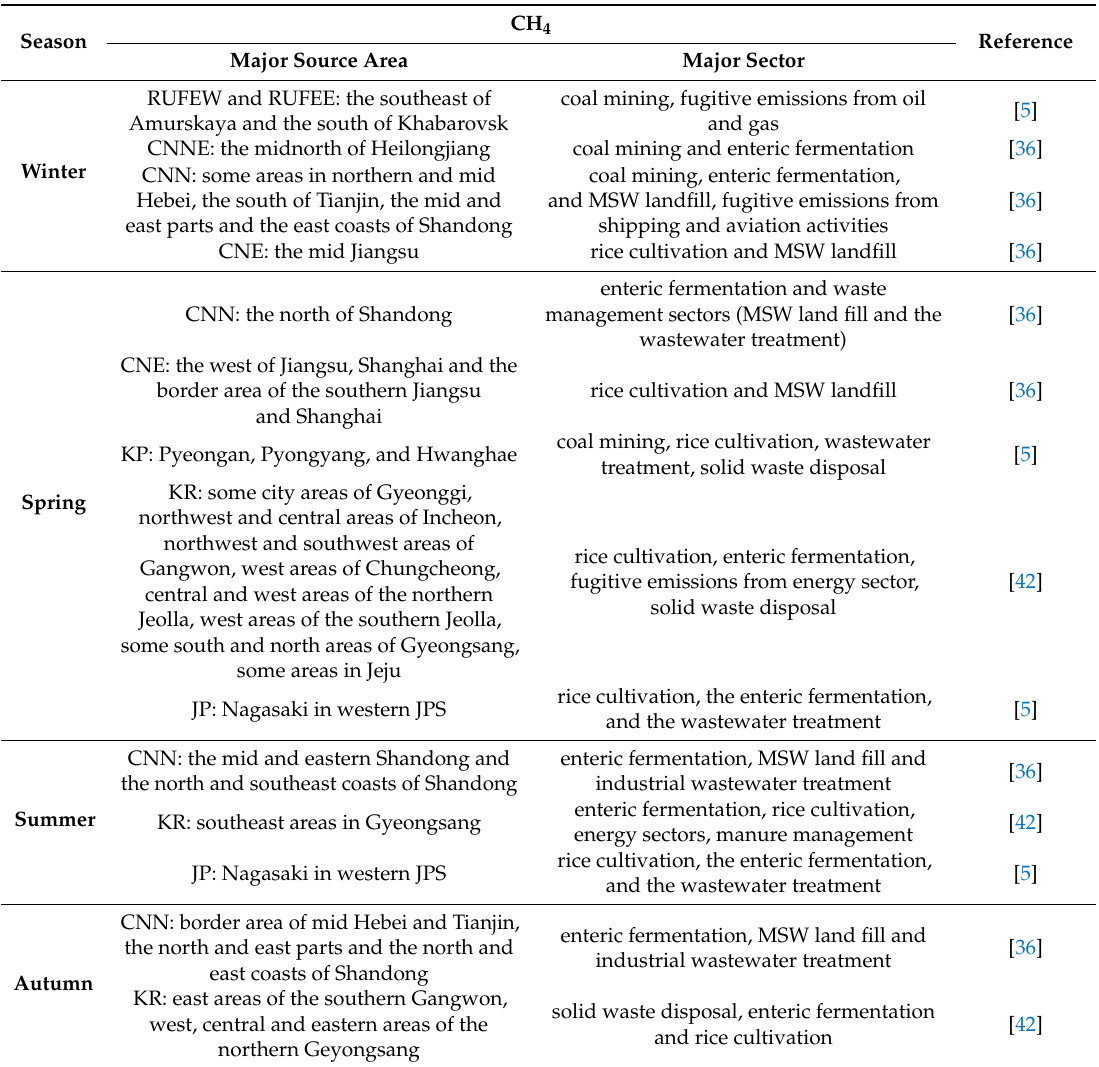
Table 4. Summary of the major source areas for CH 4 identified by the CWT